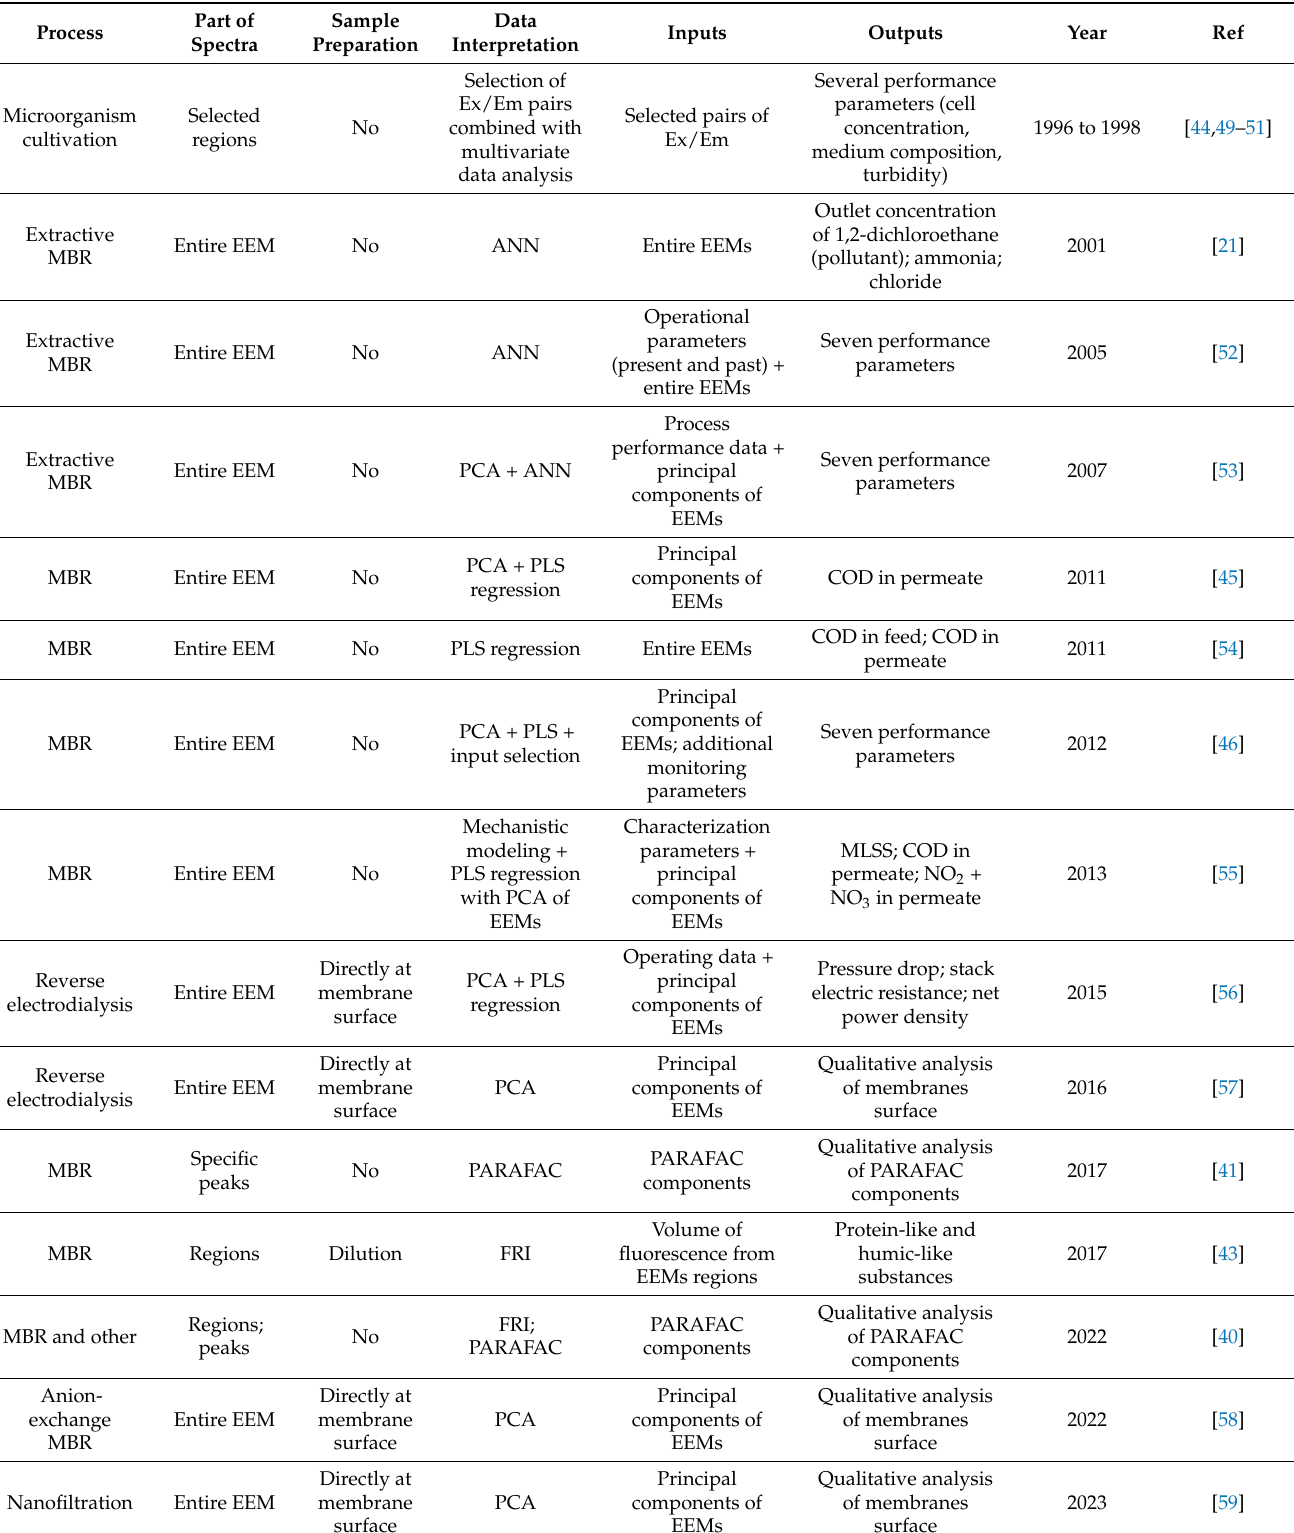
Table 1. Summary of studies using 2D fluorescence spectroscopy deconvoluted with mathematical methods for process characterization and